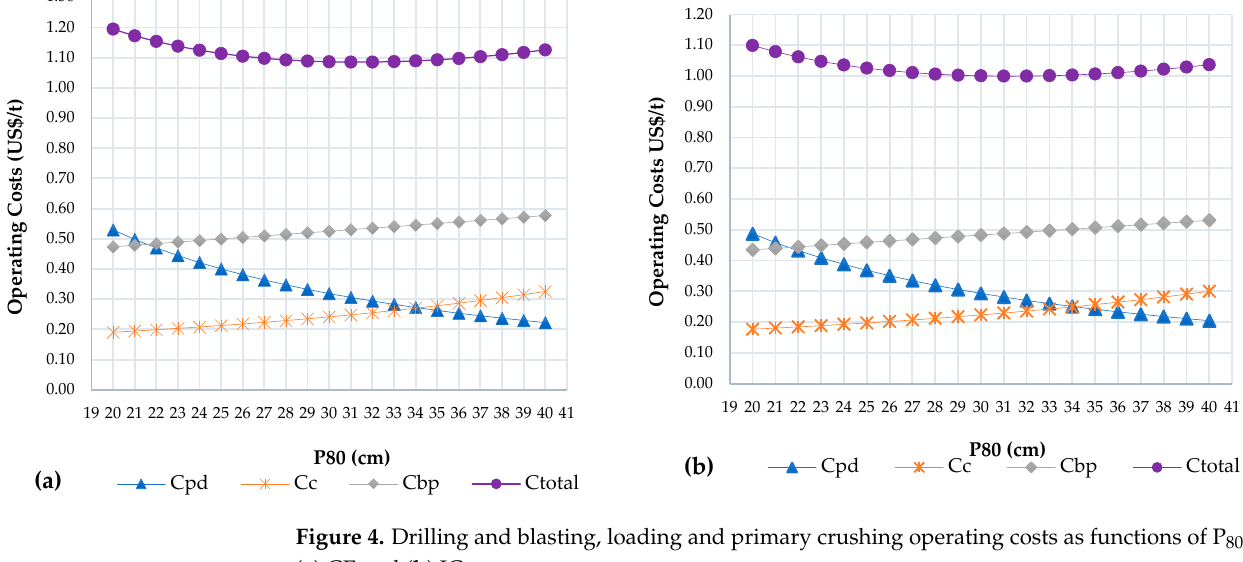
Figure 4. Drilling and blasting, loading and primary crushing operating costs as functions of P 80 for ( a ) CE and ( b ) JC.